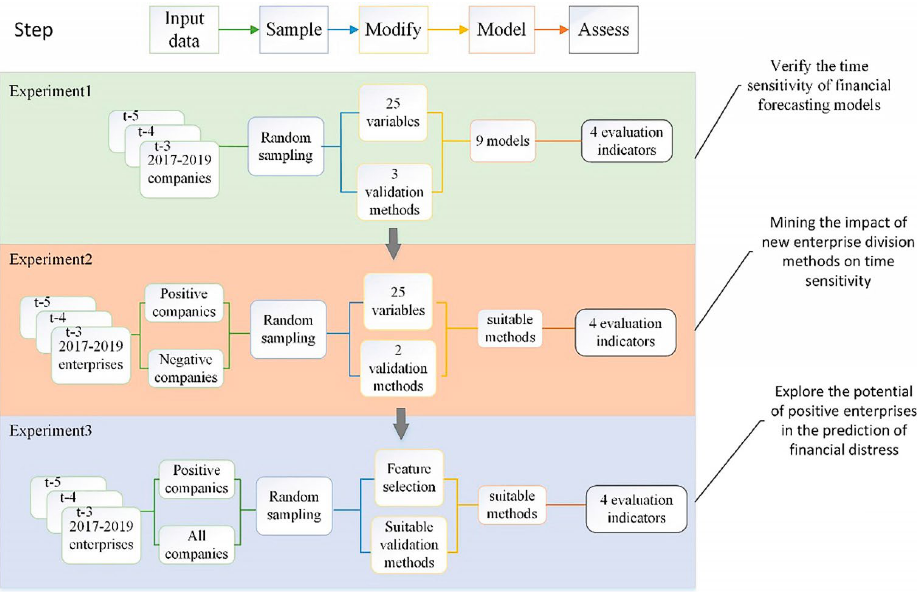
Figure 1. The procedure of the financial distress